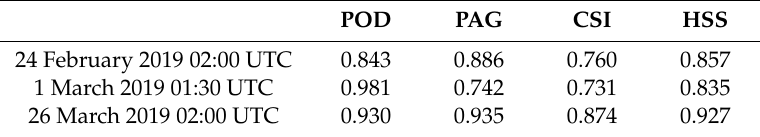
Figure 9. Results of the proposed sea fog detection algorithm for foggy and partly cloudy weather cases on ( a ) 24 February 2019, at 02:00 UTC, ( b ) 1 March 2019, at 01:30 UTC, and ( c ) 26 March 2019, at 02:00 UTC. The green and cyan colors indicate the sea fog pixels obtained using only AHI 3.9 μ m and the BTD algorithm and only the proposed sea fog algorithm, respectively. The purple color indicates that both sea fog algorithms detected pixels as sea fog. Table 4. Statistical results for foggy and partly cloudy cases.